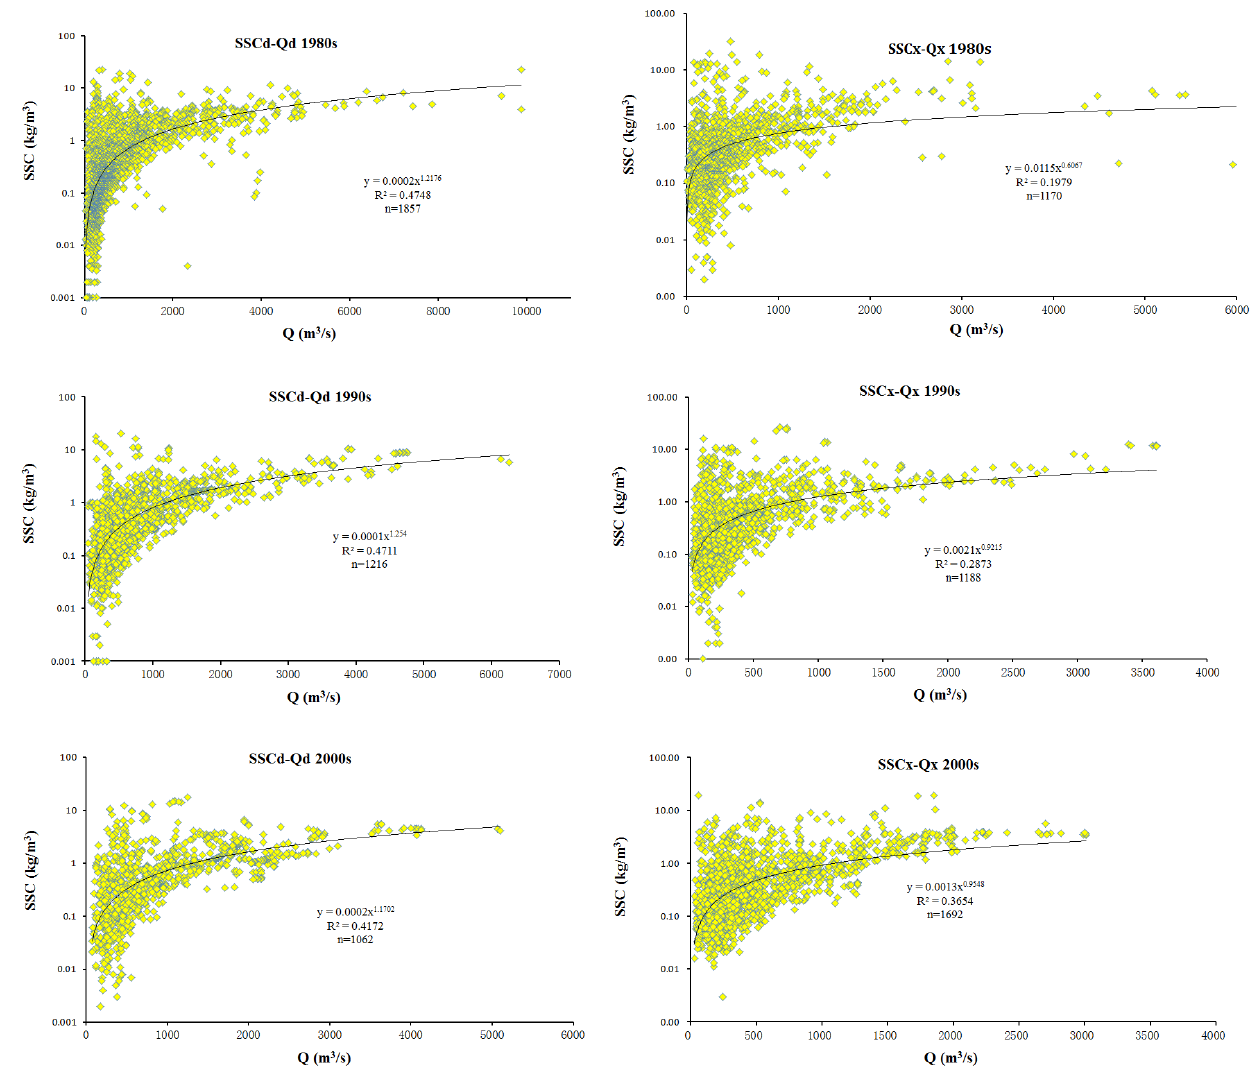
Figure 7. SSC– Q relationships during the three periods for the two gauges. Table 6. Mean SSC values and one-way ANOVA of SSCs during the different